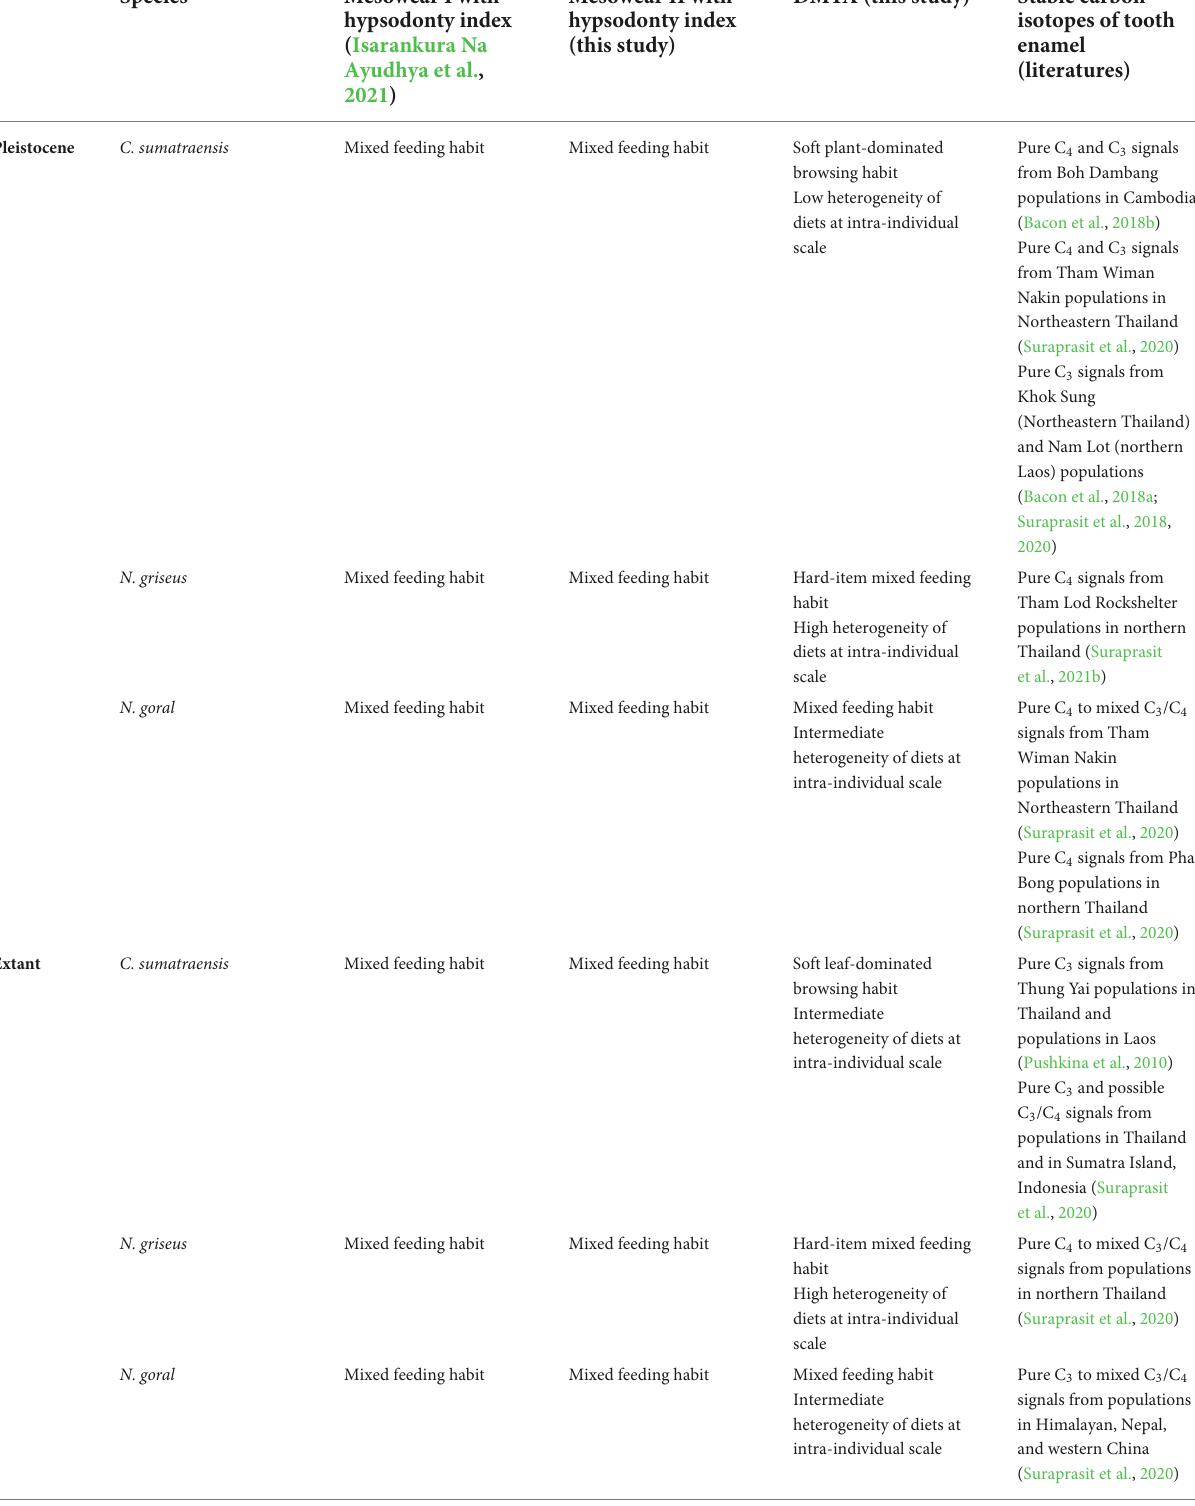
TABLE 6 Summary of dietary interpretations of Pleistocene and extant caprines based on dental wear pattern and stable carbon isotope studies.